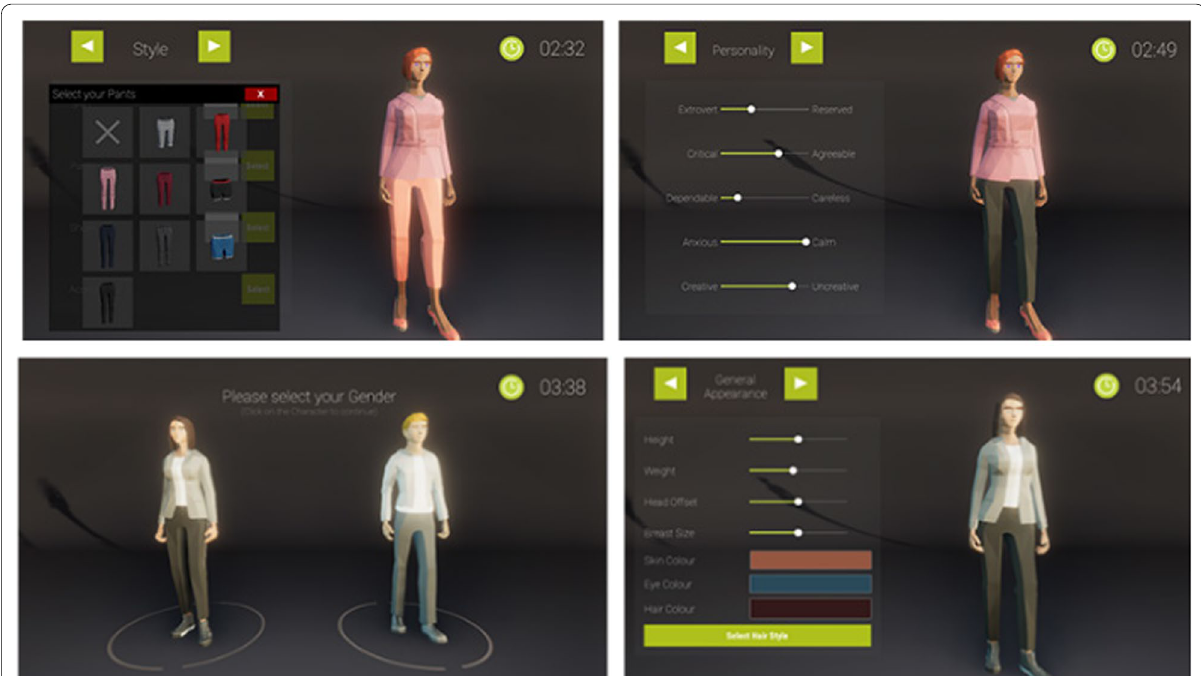
Fig. 1 Character Editor. Participants were able to customize their character’s clothing (top left), personality (top right), body type (bottom left) and physical attributes as well as body proportions (bottom right). The character was imported into the game, but neither the visual nor personality features of the customized avatar had any impact on the task